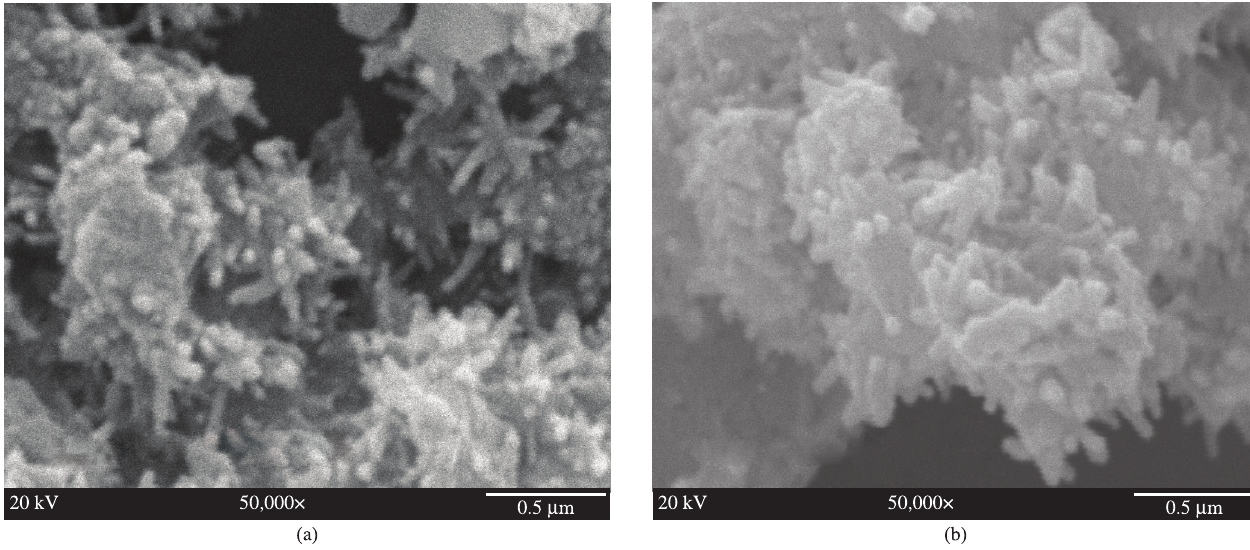
Figure 5. SEM micrographs of particles synthesized in the liquid crystal phases with: a) Renex-60 TM and b) Renex-100 TM